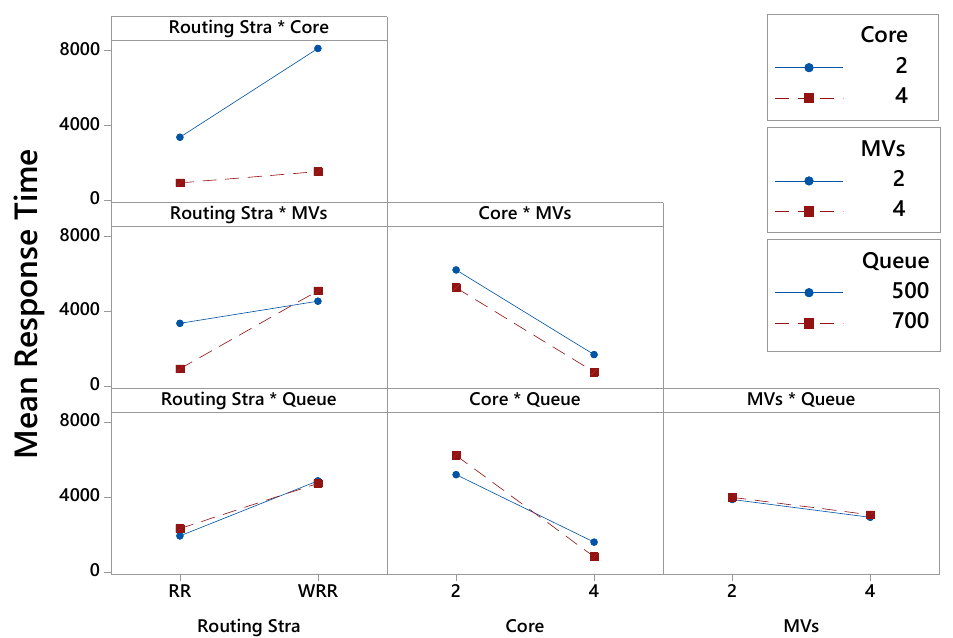
Figure 6. Interaction of factors regarding their impact on the MRT metric. The ∗ mark means the relationship between the two